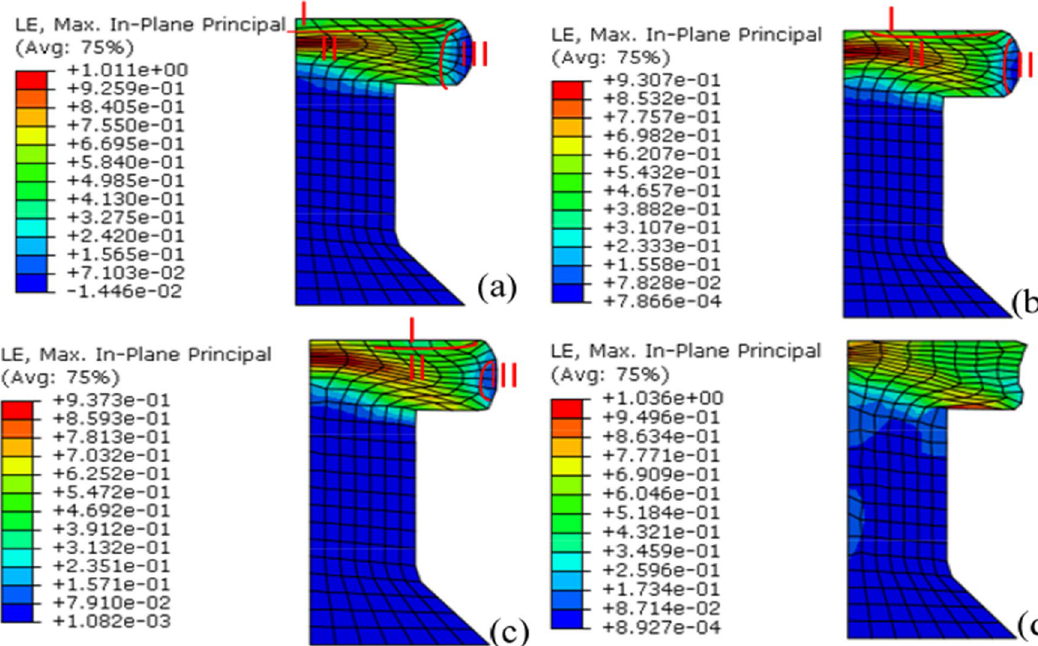
Figure 17. Strain after riveting under different vibration conditions ( a ) no vibration, ( b ) A = 1 μm, ( c ) A = 3 μm, ( d ) A = 5